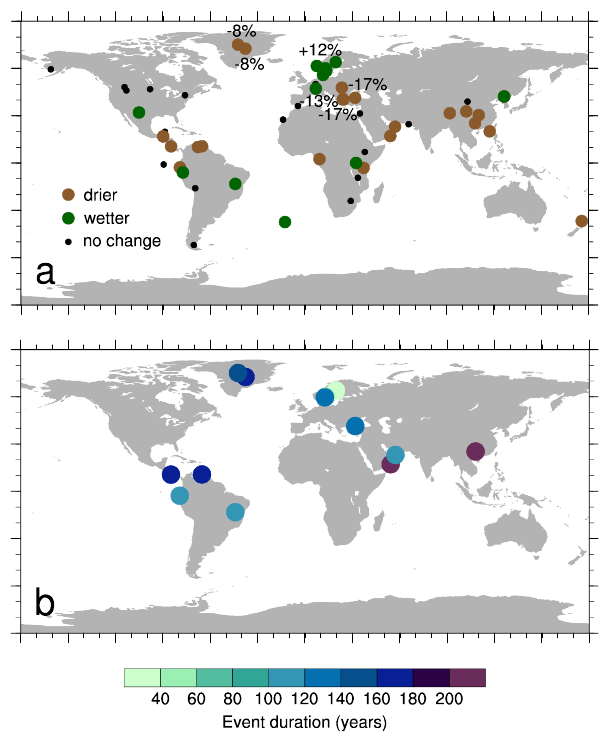
Figure 4. (a) Precipitation anomalies relative to early Holocene background climate (defined 4 Fig. 4. (a) Precipitation anomalies relative to early Holocene back- as the average between 7.4-7.9 and 8.5-9.0 calendar ka) detected near 8.2 ka by the method 5 ground climate (defined as the average between 7.4–7.9 and 8.5–9.0 calendar ka) detected near 8.2ka by the method described in text. described in text. Black dots indicate sites with precipitation proxies that did not have an 6 Black dots indicate sites with precipitation proxies that did not have identifiable anomaly. Values plotted are quantitative mean annual precipitation estimates, 7 an identifiable anomaly. Values plotted are quantitative mean an- expressed as a percent difference from values averaged for 7.4-7.9 and 8.5-9.0 calendar ka 8 nual precipitation estimates, expressed as a percent difference from BP, and are also presented in Table 2. (b) Duration of precipitation anomalies in high-9 values averaged for 7.4–7.9 and 8.5–9.0 calendar ka BP, and are resolution (better than 15 yrs/sample) proxies, as determined using the method of Wiersma et 10 also presented in Table 2. (b) Duration of precipitation anomalies al. (2011). 11 in high-resolution (better than 15yr/sample) proxies, as determined 12 using the method of Wiersma et al.